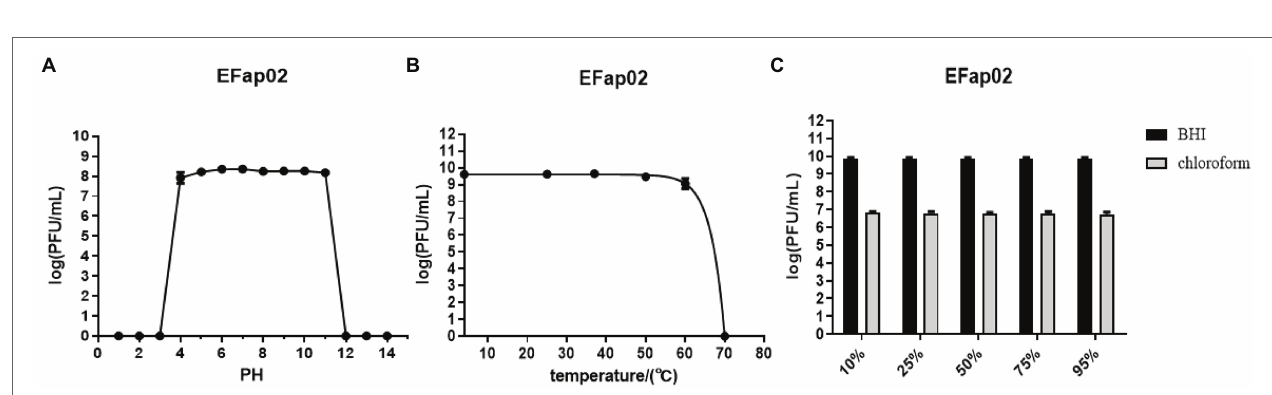
FIGURE 1 | Phage EFap02 general biological characteristics. (A) Phage plaques on a double-layer agar plate of EFap02. (B) TEM image of phage EFap02. EFap02 has an icosahedral head (length 44 nm ± 5, width 40 nm ± 5) and a long tail (210 nm ± 5). The scale bar in the right corner is 50 nm. (C) Different multiplicities of infection (MOI) of EFap02. When the MOI was 0.0001, the EFap02 titer was the highest. (D) One-step growth curve of EFap02.